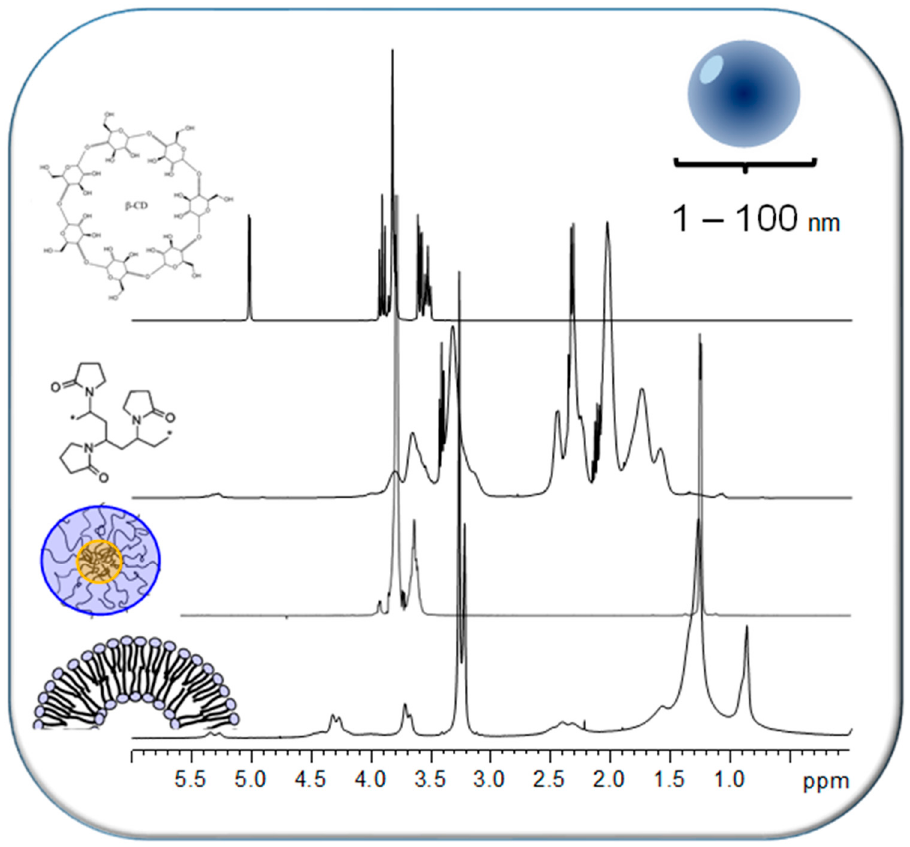
Figure 6. 1 H NMR spectra of selected polymeric nanoparticles used for drug delivery in aqueous solutions, from bottom to top: DOPC SUVs, triblock copolymer (PEG ‐ PPG ‐ PEG) micelles, polyvinylpyrrolidone (PVP) and β‐ cyclodextrin (CD).